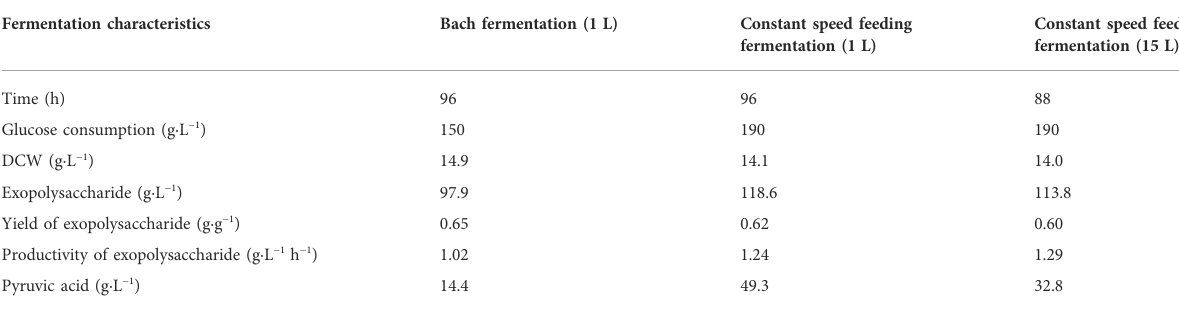
TABLE 1 Fermentation characteristics in 1-L and 15-L fermenters. Fermentation